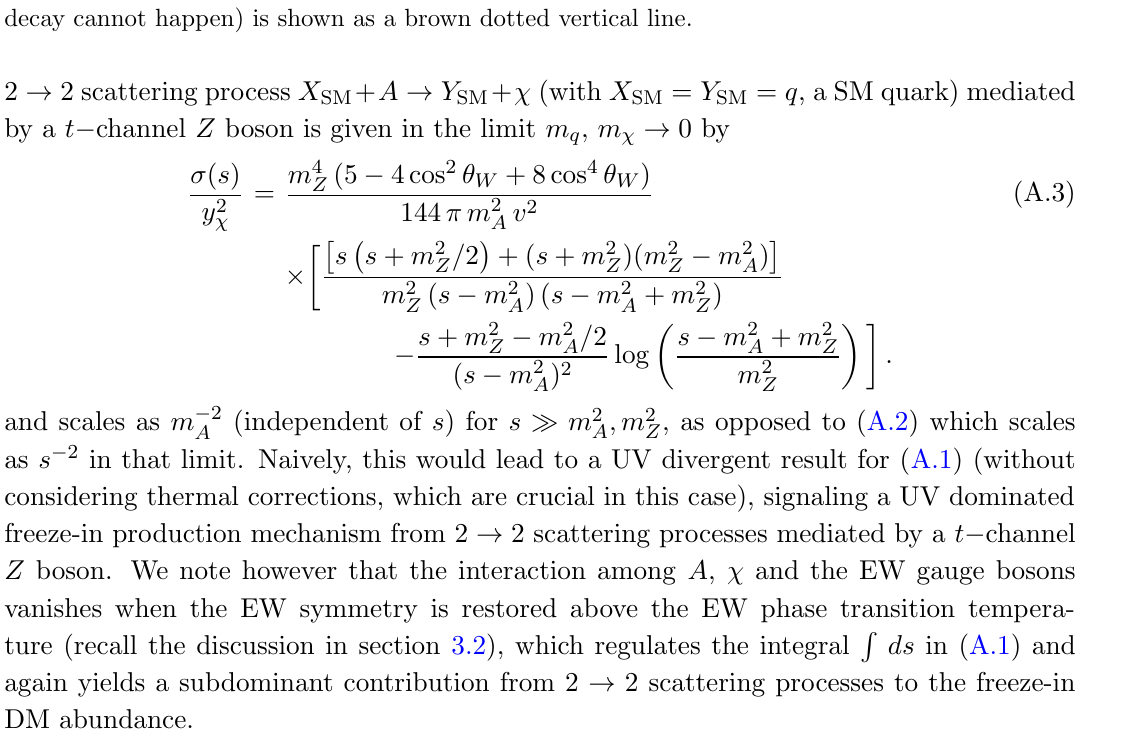
2 for m and 1 3 for m ) to 2 2 freeze-in DM A > m h A < m h ! ! ! Y Decay ) as a function of m A and for m (cid:31) = 0, neglecting m q (green) q dependence (blue). The boundary m = m (below which the 1 2 t A h !